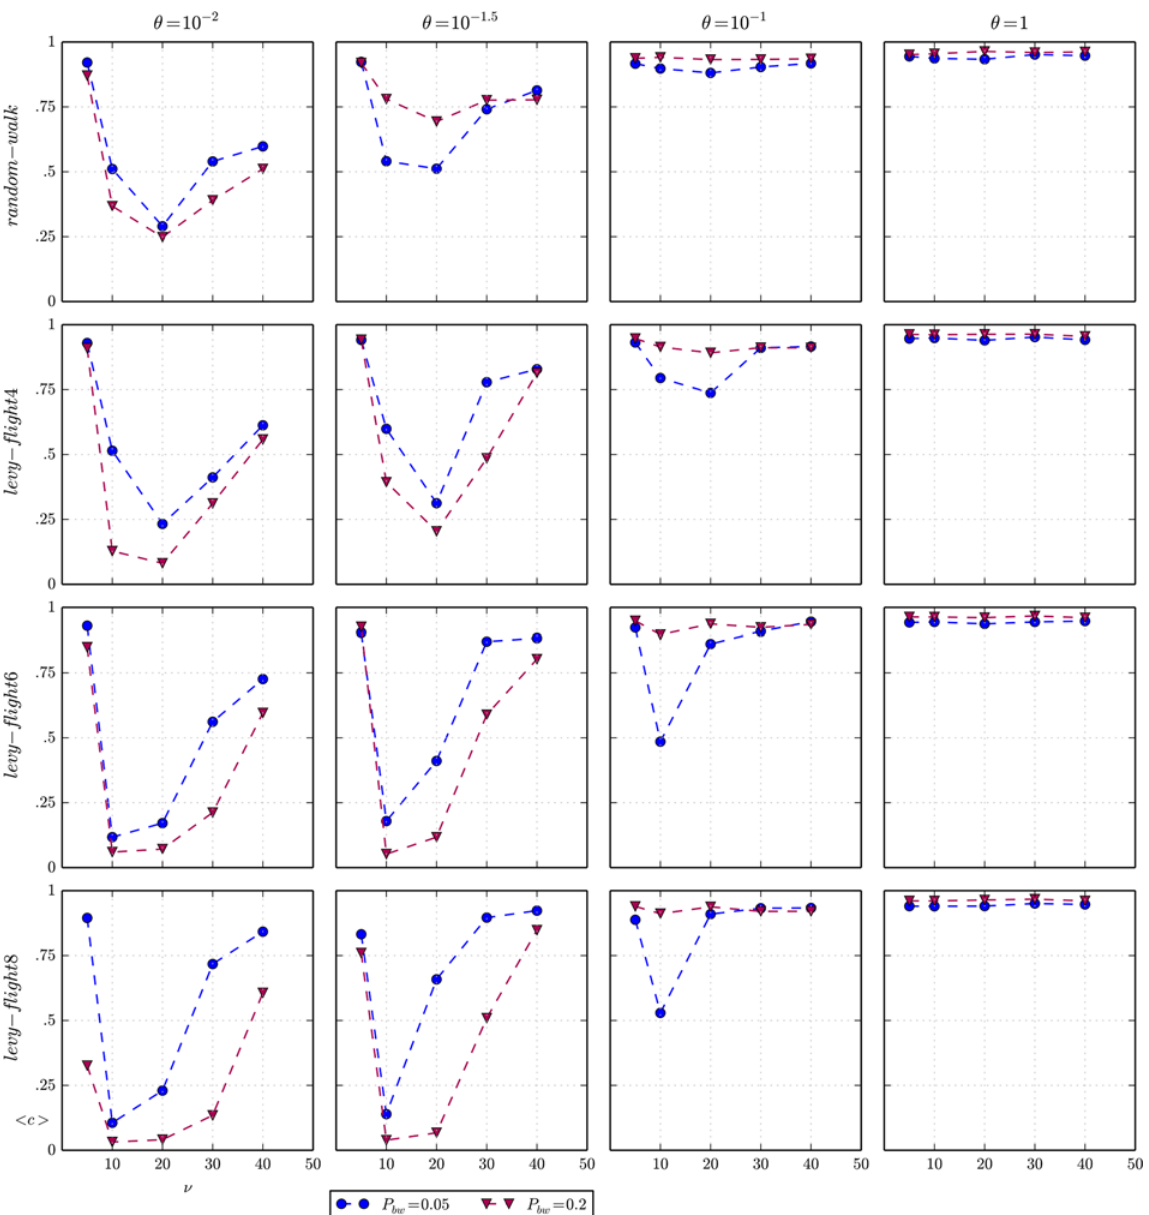
Fig 8. Average cooperation and movement. Matrix of plots of the average cooperation < c > as a function of vision ν for different agents ’ types of movement (columns) and levels of importance of social capital θ (rows), when the spatial distribution of beached whales is uniform. The maximum standard error of the average of cooperation of all experiments represented in the plots is